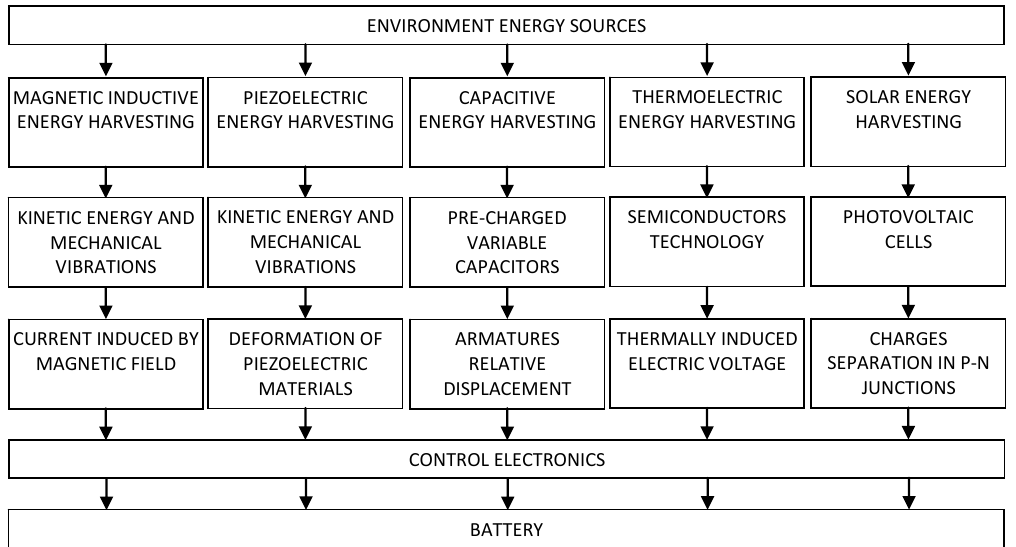
Table 1: Some typologies of energy